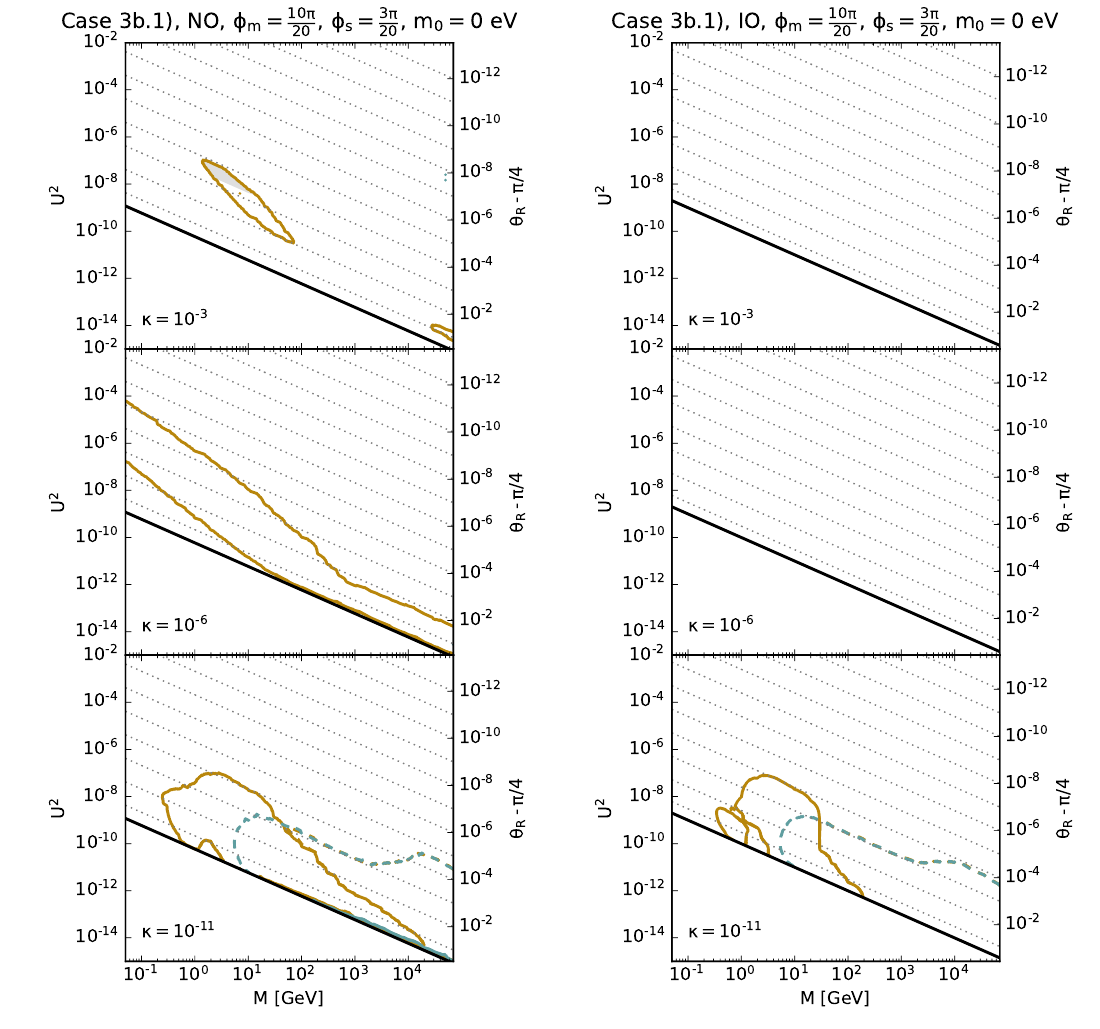
Figure 40 . Case 3 b.1) Range of total mixing angle U 2 consistent with the observed BAU for heavy neutrino masses between 50 MeV and 70 TeV, as presented in figure 25. The three rows correspond to different values of κ , κ ∈ { 10 − 3 , 10 − 6 , 10 − 11 } , respectively. The vanishing and thermal initial conditions are shown by the ochre and turquoise lines, respectively. The continuous (dashed) lines indicate positive (negative) values of the BAU. The grey shaded area shows the region in which a condition like the one in eq. (3.69) is no longer